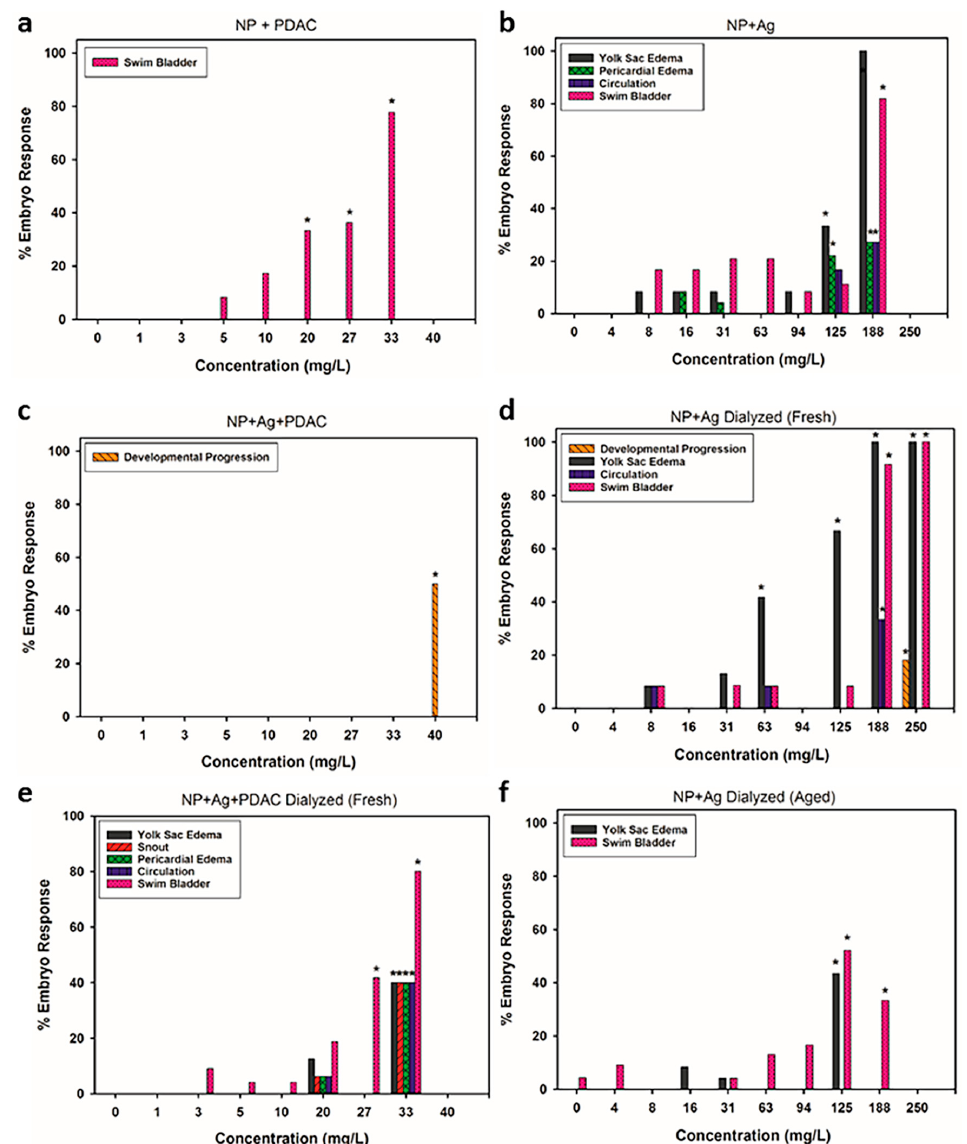
Figure 3. Types of developmental and morphological abnormalities observed in 120 hpf zebrafish embryos exposed to various formulations of the nanoparticles including ( a ) NP + PDAC, ( b ) NP + Ag, ( c ) NP + Ag + PDAC, ( d ) NP + Ag Dialyzed (Fresh), ( e ) NP + Ag + PDAC Dialyzed (Fresh) and ( f ) NP + Ag Dialyzed (Aged). Asterisk represents significant increase relative to unexposed (control) fish embryos at p ≤ 0.05.